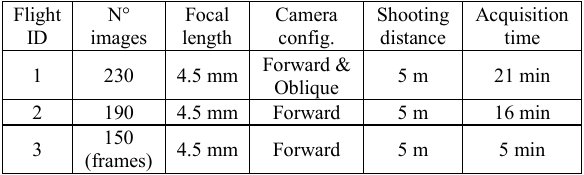
Table 2. Summary of the performed flights with the related